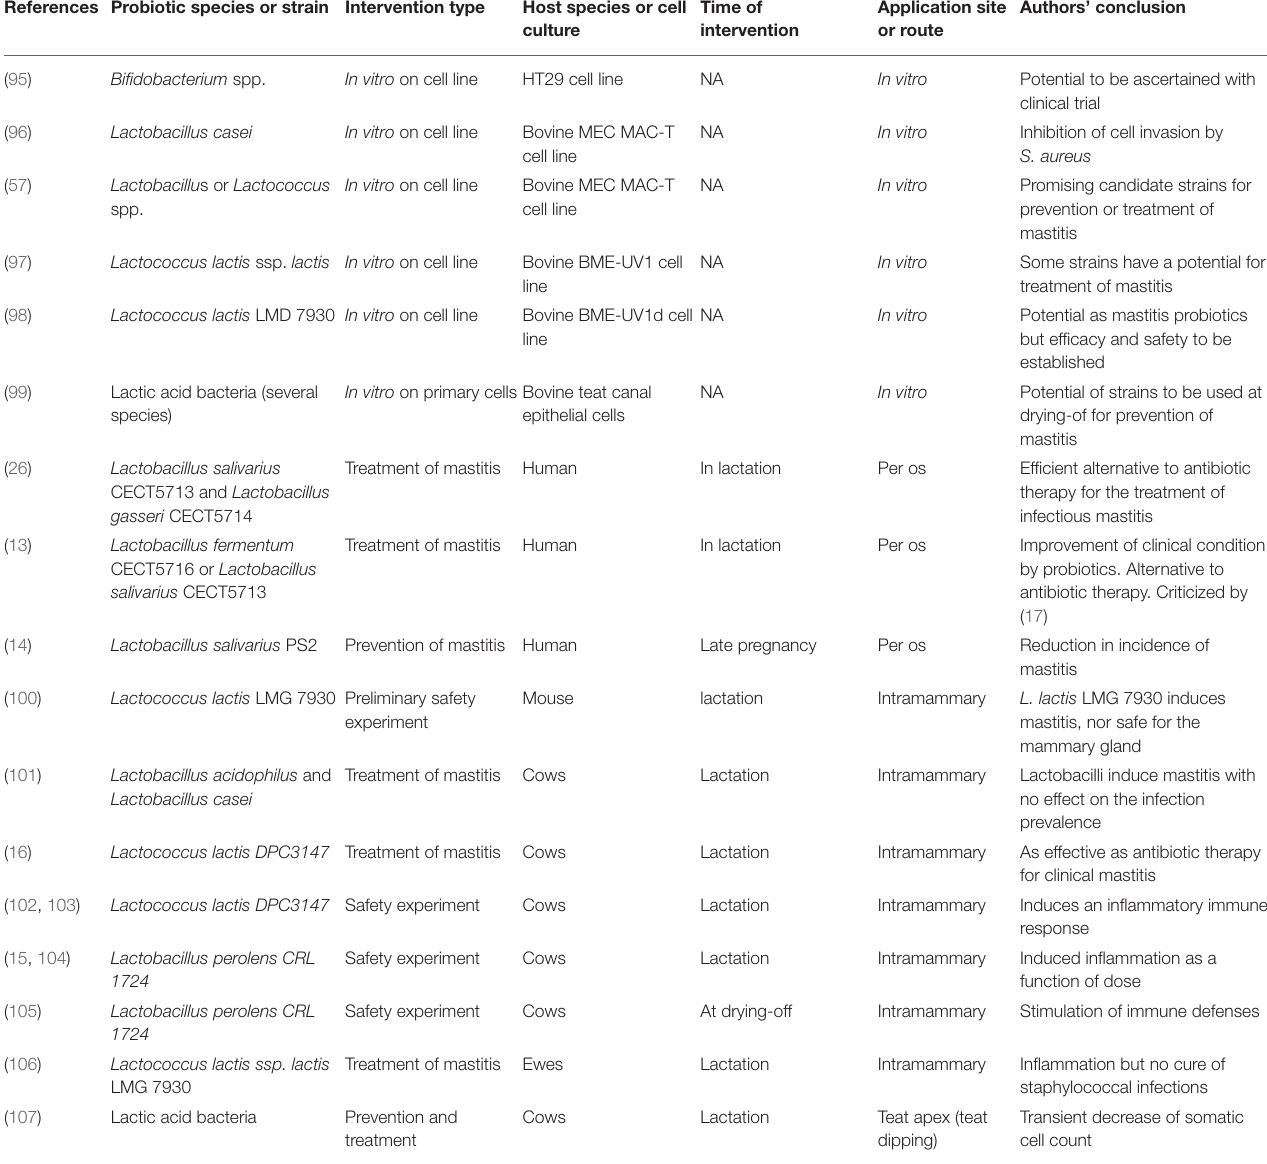
TABLE 1 | Study characteristics of 19 included manuscripts evaluating the potential of probiotics for the prevention or treatment of mastitis. References Probiotic species or strain Intervention